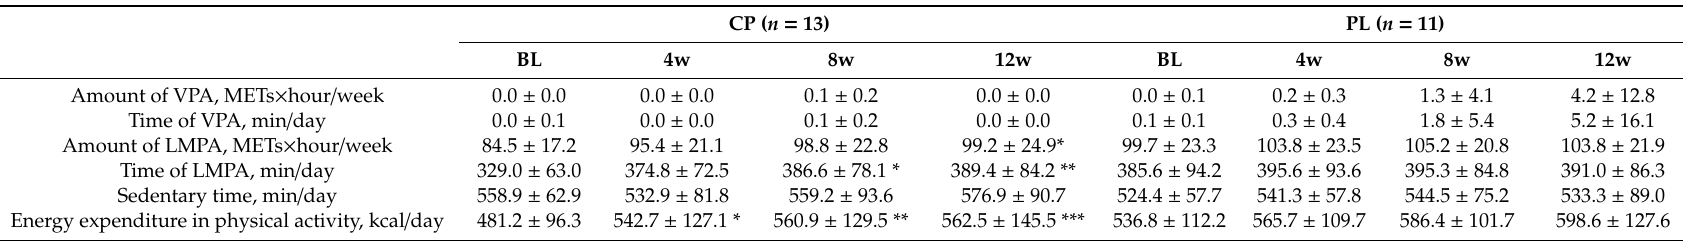
Table 4. Amount of vigorous and light-to-moderate physical activity and time spent in vigorous, light-to-moderate, and sedentary physical activity in inactive subjects. CP ( n = 13) Amount of VPA, METs × hour /